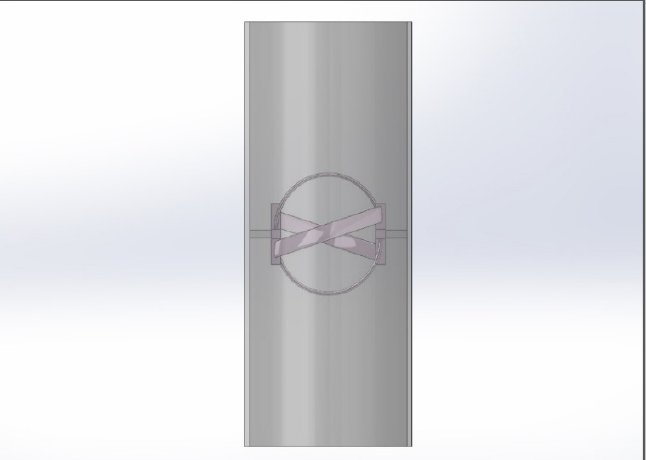
Figure 10. The turbine assembly with the pipe.